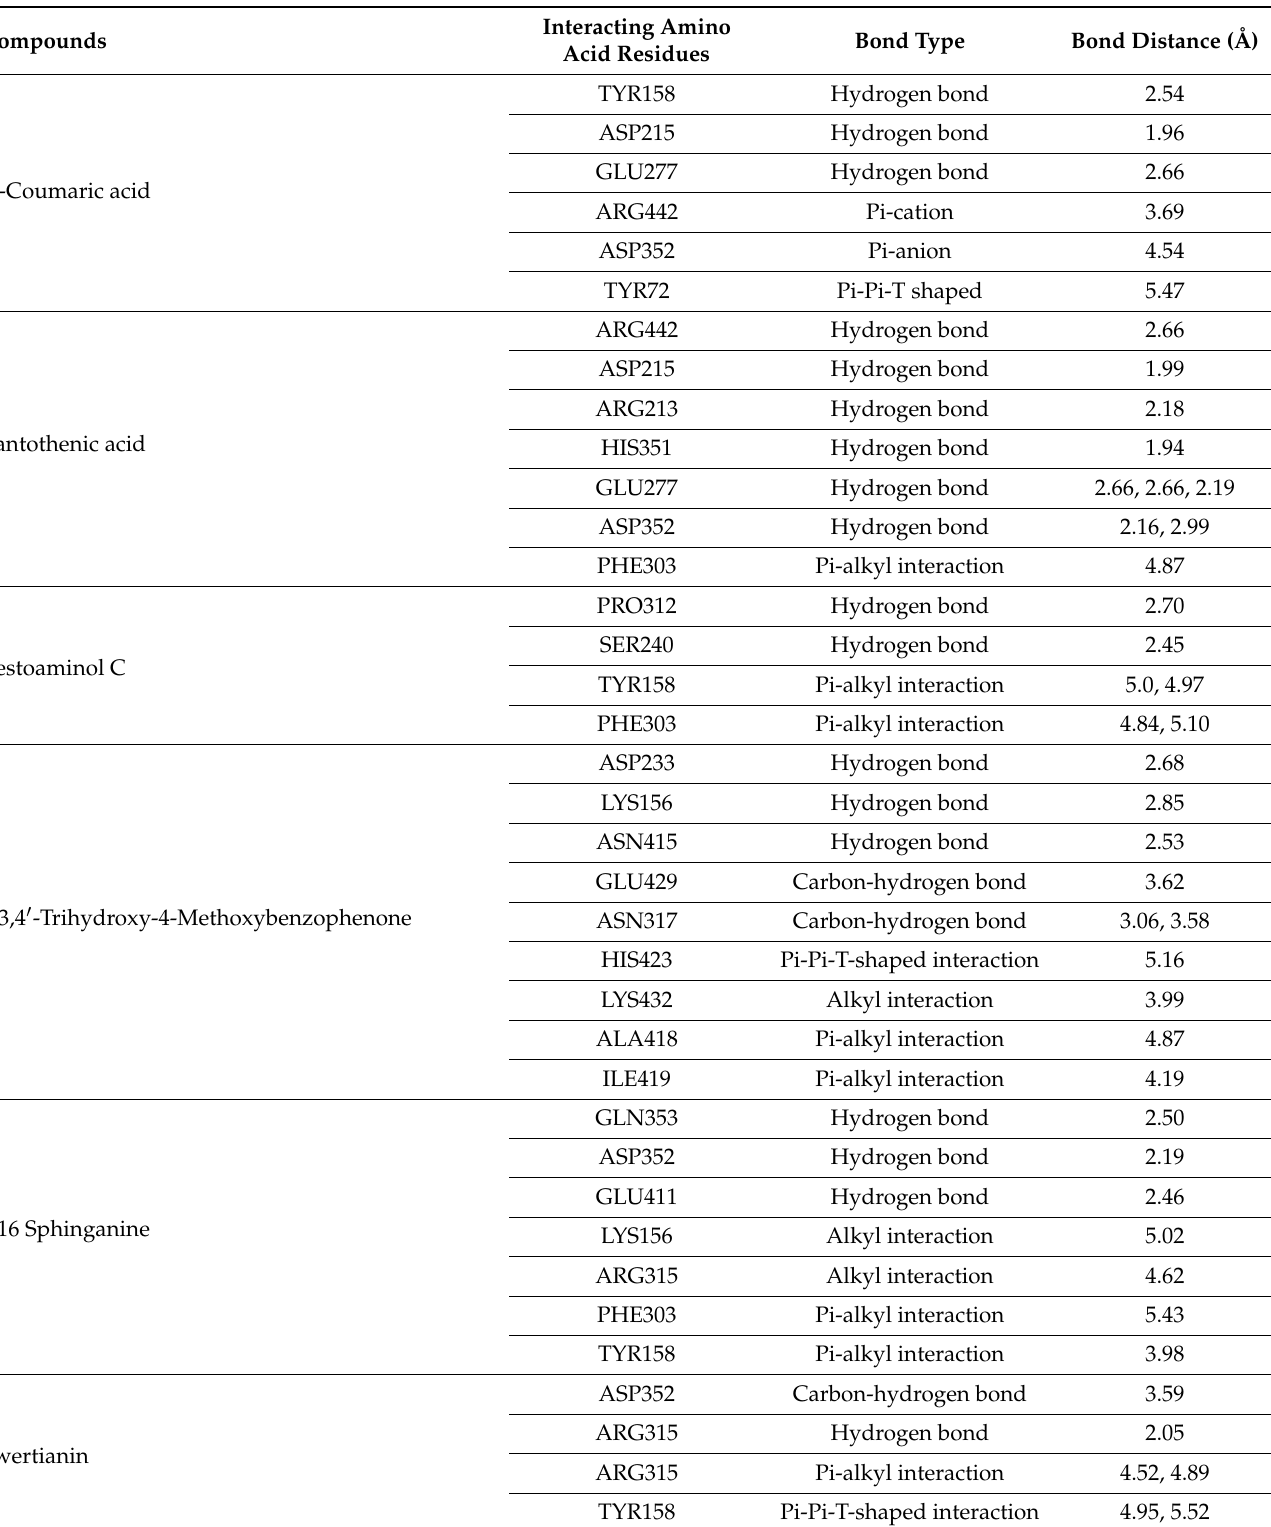
Table 6. Identified Q-ToF-LCMS compounds and their amino acid residues, bond type and bond